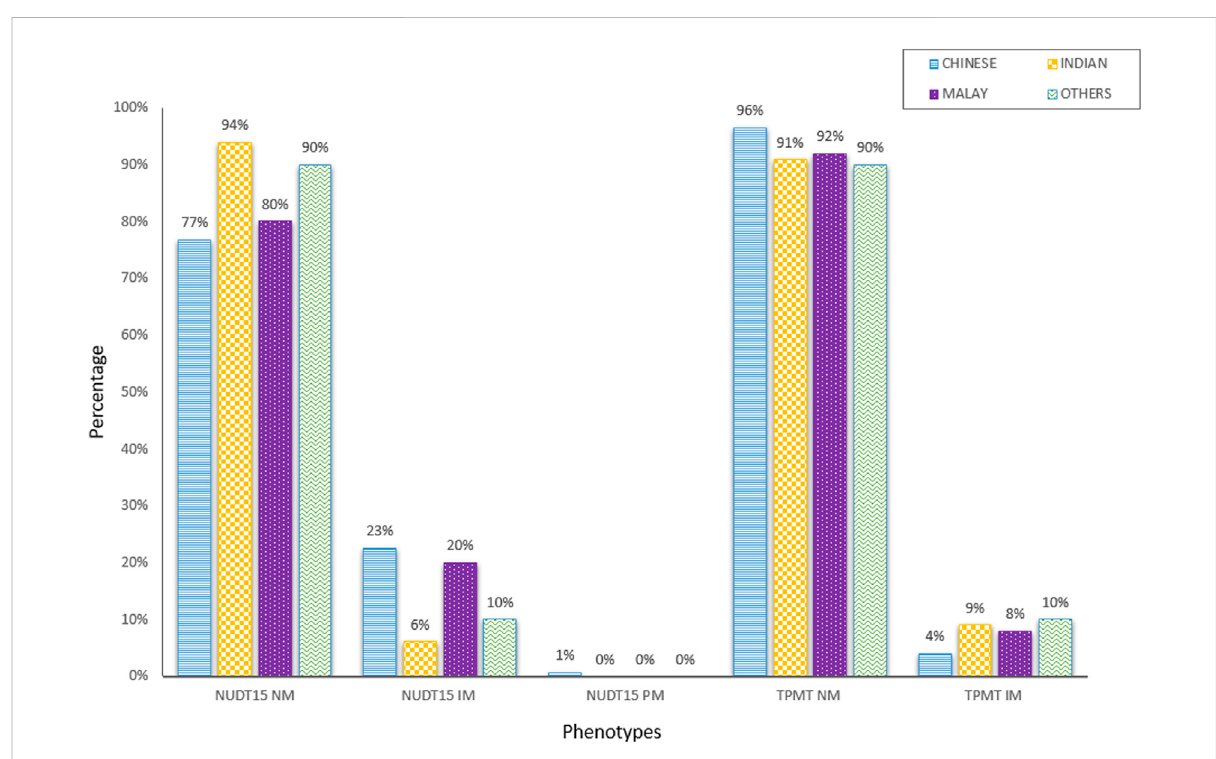
FIGURE 2 Distribution of NUDT15 and TPMT diplotypes and phenotypes among different ethnic groups (N =